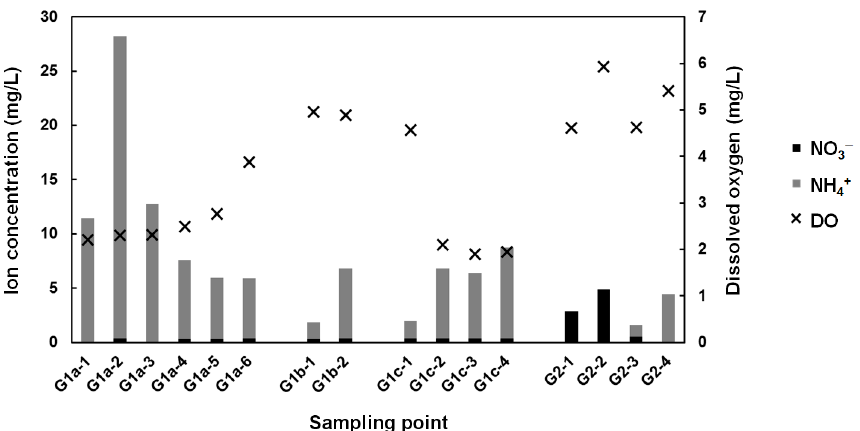
Figure 6. Relationship between NO 3 − , NH 4+ , and DO (dissolved oxygen) concentration in the Galing River.